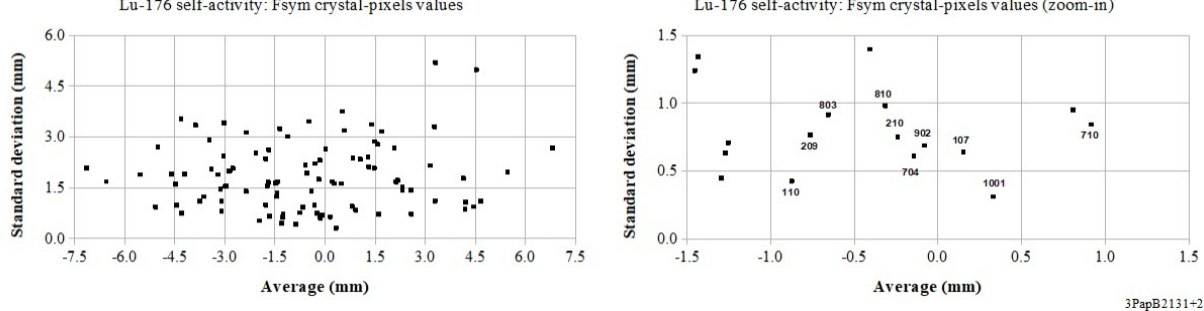
Figure A17. Plot of standard deviation Vs. average of Fsym values ( left ) obtained for all the crystal-pixels of the 10 × 10 array from Lu-176 self-activity data. A relevant overall dispersion of results is shown, suggesting to search for a subset of pixels showing the most similar symmetry properties. Zoom-in ( right ) of the central-zone of the plot on the left, showing the decuple of pixels with the smaller charge-spread values around the origin. The selected decuple was, in RRCC ascending order, 107, 110, 209, 210, 704, 710, 803, 810, 902, and 1001 with distance-values from origin ranging from 0.31- to 0,98-mm.